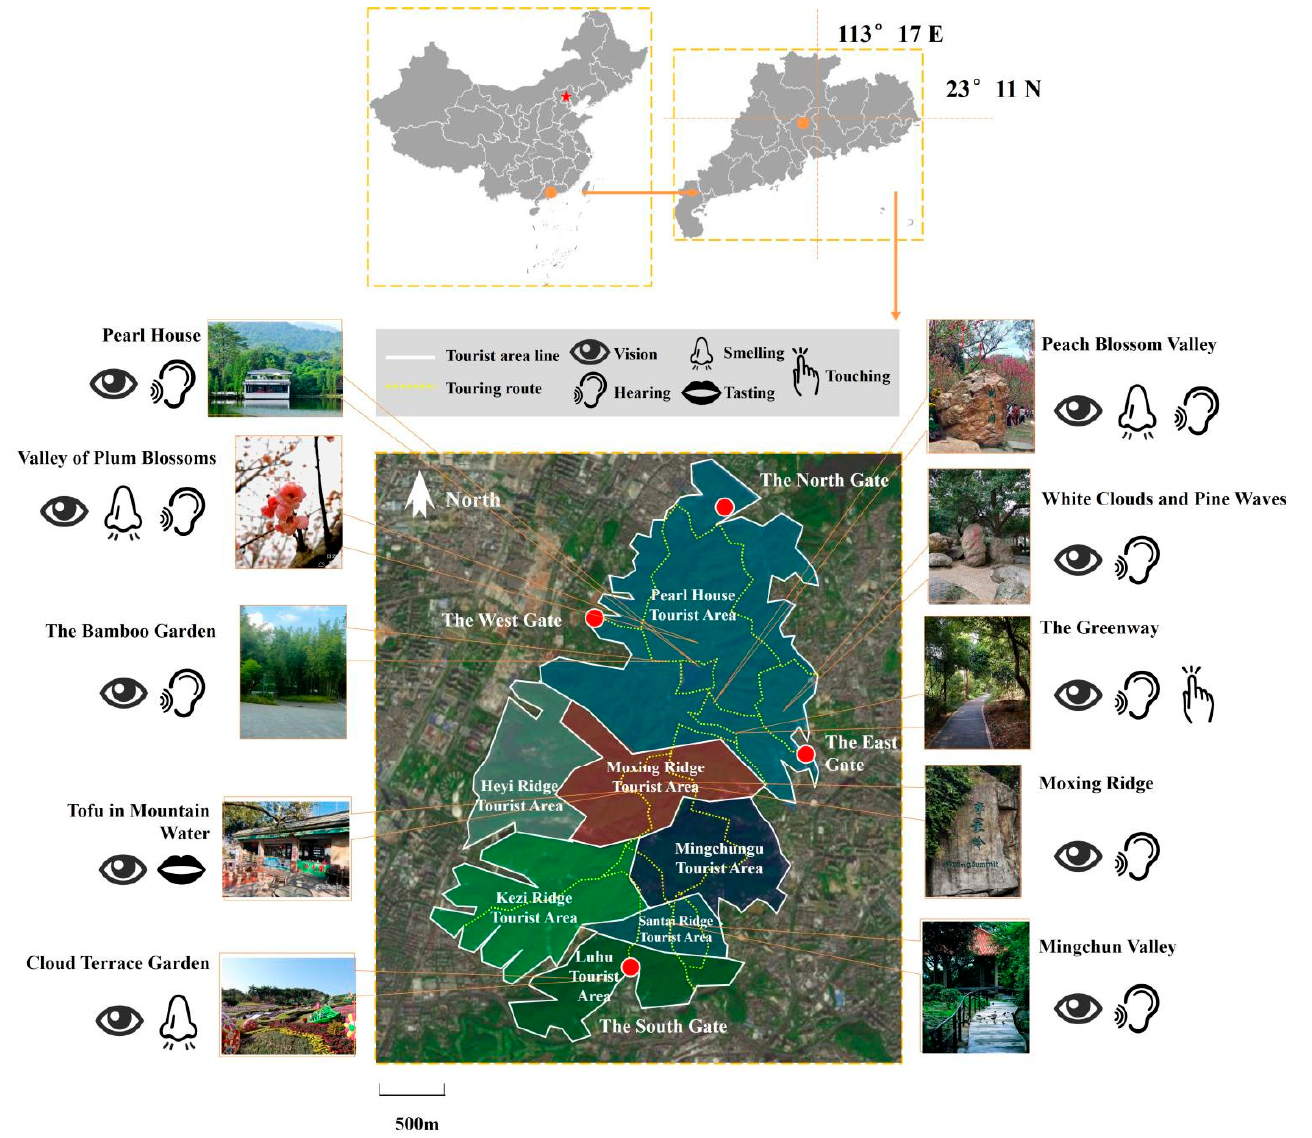
Figure 2. The map of Guangzhou Baiyun Mountain Urban Forest Park.